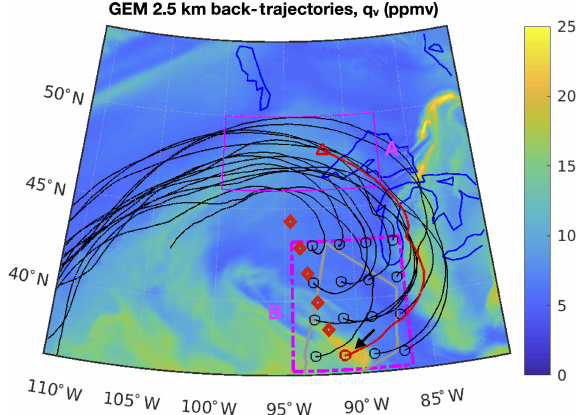
Figure 7. Back trajectories of air parcels. All the trajectories, in black lines, are initialized in Domain B at 15.5km altitude and 19:40UTC, 27 August. The circles indicate the initial locations of each back trajectory. The grey line illustrates the ER-2 aircraft flight path (in clockwise direction). The background image shows the wa- ter vapour content inppmv at this level from the 2.5km simulation. The red line highlights the back trajectory of one air parcel from its initial location in Domain B to its location in Domain A at around 23:00UTC, 25 August 2013, when the overshooting convection oc- curred. The evolution of the properties of this air parcel are shown in Fig. 8. The red diamonds indicate the centre of five MLS footprints on 26 August.